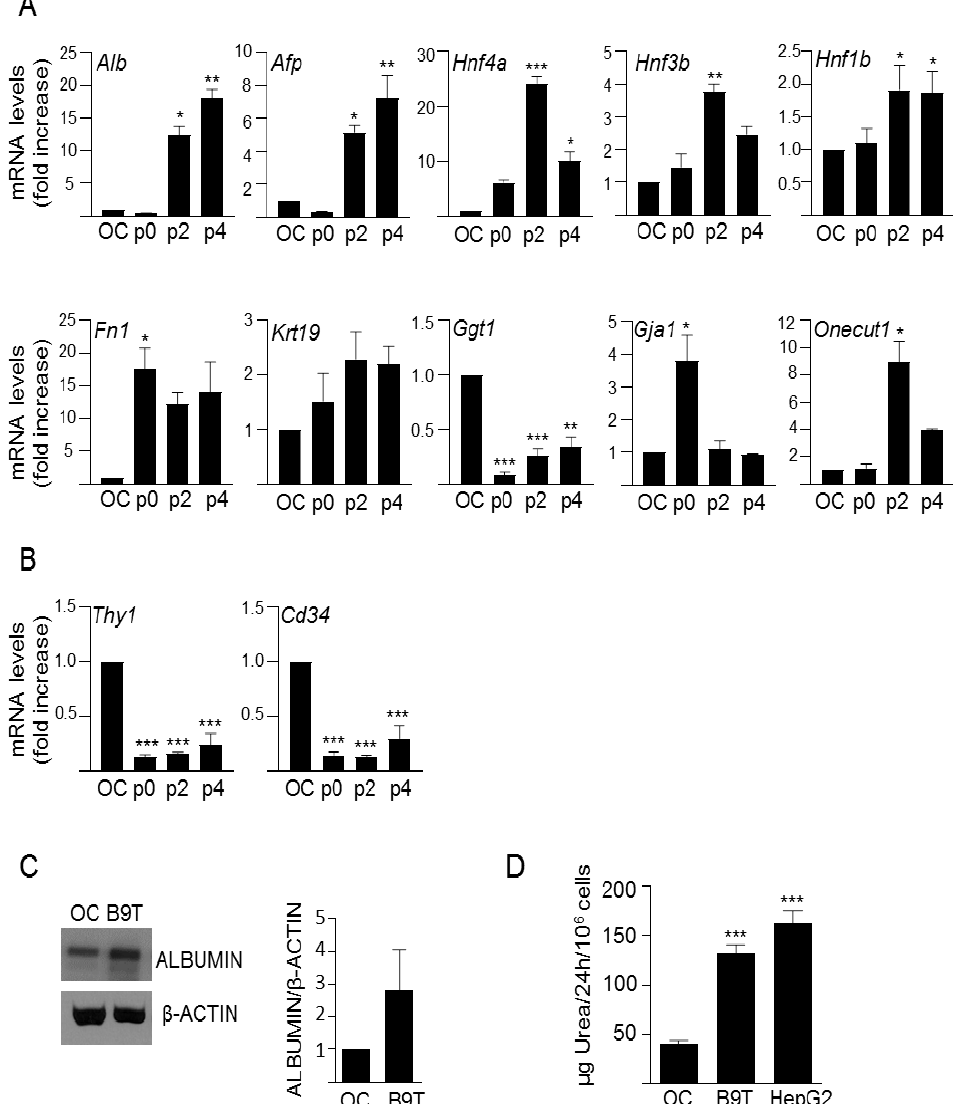
Figure 2. Analysis of lineage markers in B9T-OC cells. ( A , B ) RT-qPCR analysis for the expression of ( A ) hepatocyte and biliary markers, and ( B ) hematopoietic stem/progenitor cell markers. Gusb was used for normalization. Data are expressed relative to oval cells (assigned an arbitrary value of 1) and are mean ± SEM of three independent experiments. * p < 0.05, ** p < 0.01 and *** p < 0.001 B9T-OC vs. OC. ( C ) Western blot analysis for ALBUMIN and β -ACTIN (used as loading control) in oval cells (OC) and B9T-OCs (B9T) cultured in the absence of serum for 15 h. A representative experiment (left panel) and a densitometric analysis (right panel) are shown. Data corresponding to optical density values relative to loading control are mean ± SEM of three independent experiments and are expressed relative to OC samples (assigned an arbitrary value of 1). ( D ) Urea levels from oval cells (OC) and B9T-OCs supernatants were measured spectrophotometrically. HepG2 cells were used as positive control. Urea rate production was expressed as µ g/24 h/10 6 cells. Mean ± SEM ( n = 5) is displayed. Statistical analysis was carried out using the paired t -test and data were compared to oval cells (OC), *** p < 0.001.